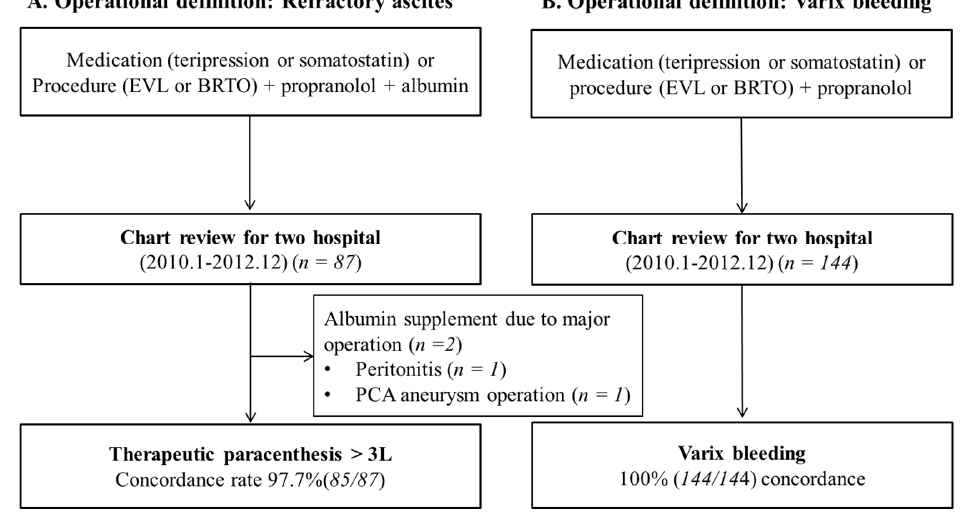
Figure 2. Validation of operational definition. ( A ) Variceal bleeding with large-volume ascites, ( B ) Variceal bleeding.